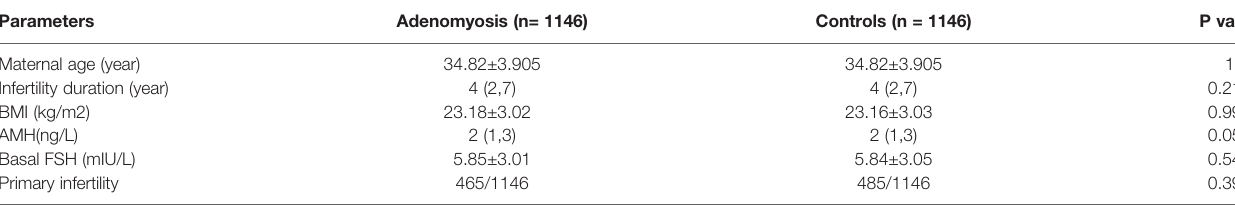
TABLE 1 | Baseline characteristics of the study